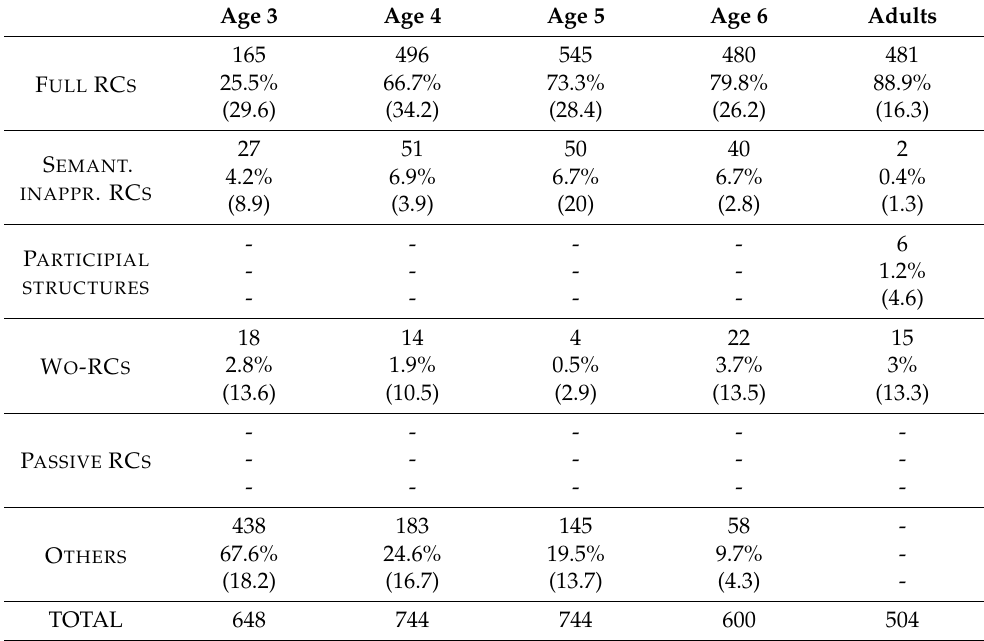
Table 2. Raw scores, percentages (%), and standard deviations (N) of the five structures produced in the agent-modifying condition for each age